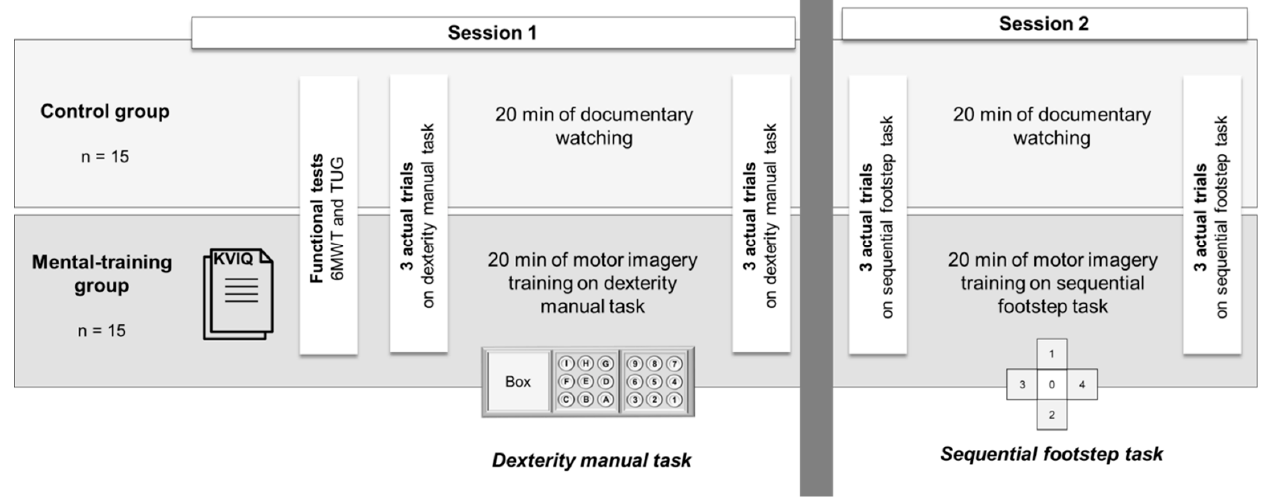
Figure 1. Illustration of the experimental